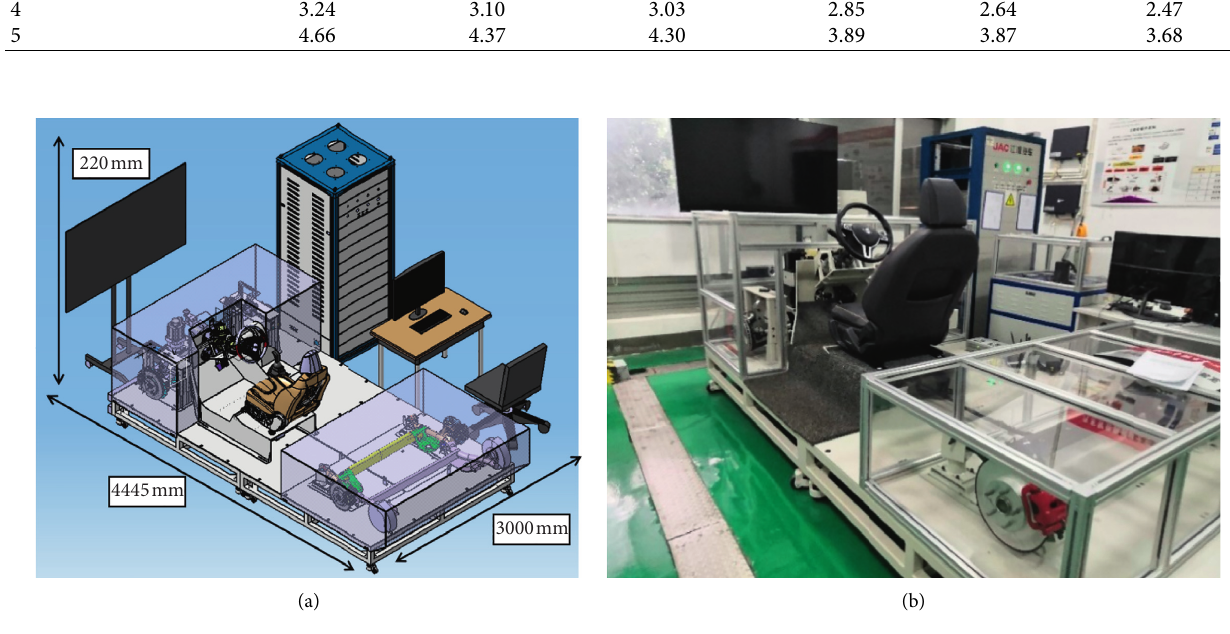
Figure 14: Experimental simulation platform: (a) design of the simulation platform; (b) photo of the simulation platform.